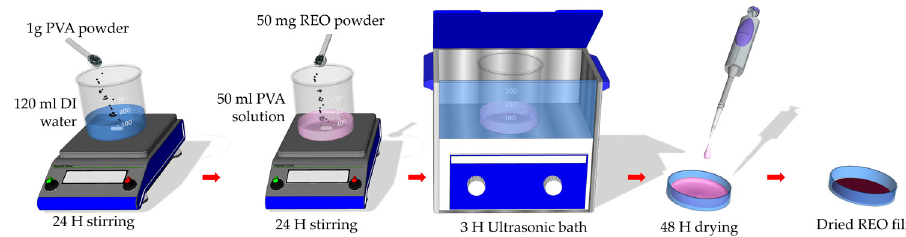
Figure 1. The fabrication of Y 2 O 3 -PVA